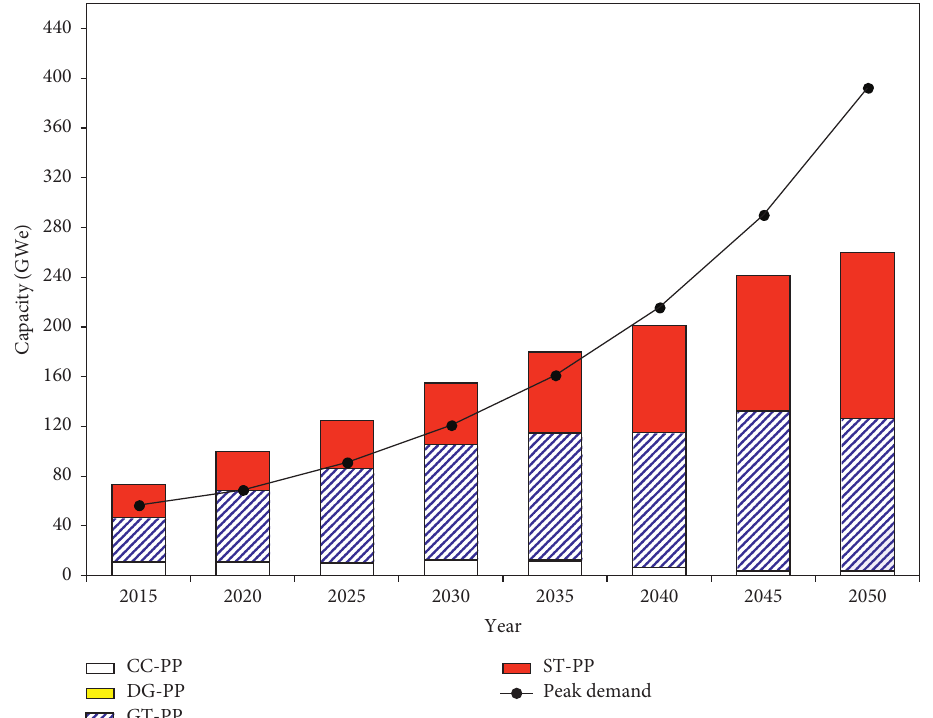
Figure 5: Simulation results from MESSAGE tool for Scenario